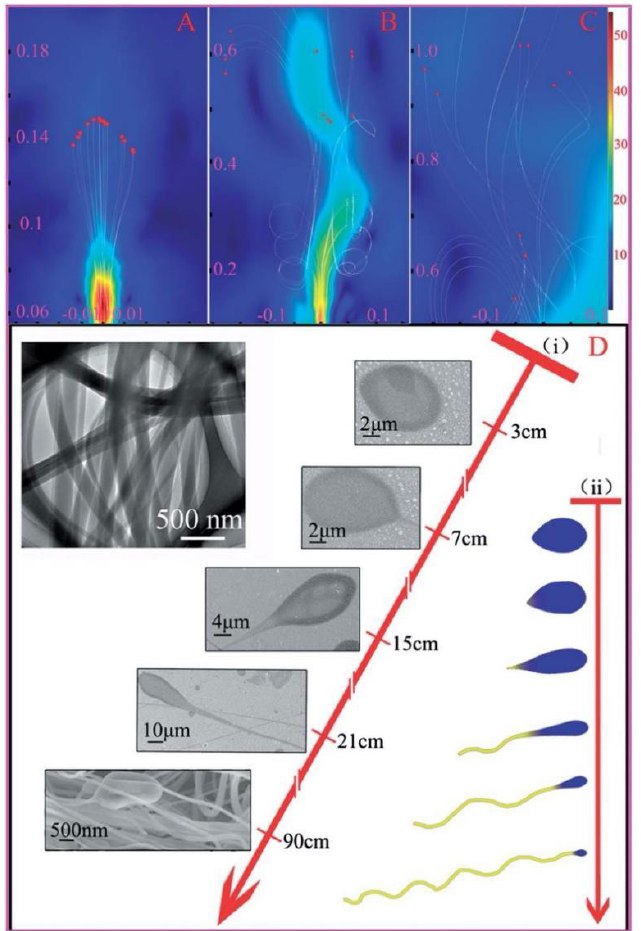
Figure 7. Fiber forming mechanism via high-pressure gas spinning. ( A – C ) show the particles’ track after they had moved for 0.005, 0.075 and 0.12 s, respectively. ( D ) Proposed mechanism to explain the formation of nanofibers in the extrusion spray spinning process. (i) Scanning electron micrographs of the PVP nanofiber (or droplet) collected at different locations from 3 to 90 cm away from the spray nozzle. The inset is a transmission electron micrograph of the PVP nanofibers collected 180 cm away from the spray nozzle. (ii) Schematic illustrations showing the development from the original PVP droplets to PVP nanofibers. (Reprinted with permission from Ref. [29]. 2012 Royal Society of